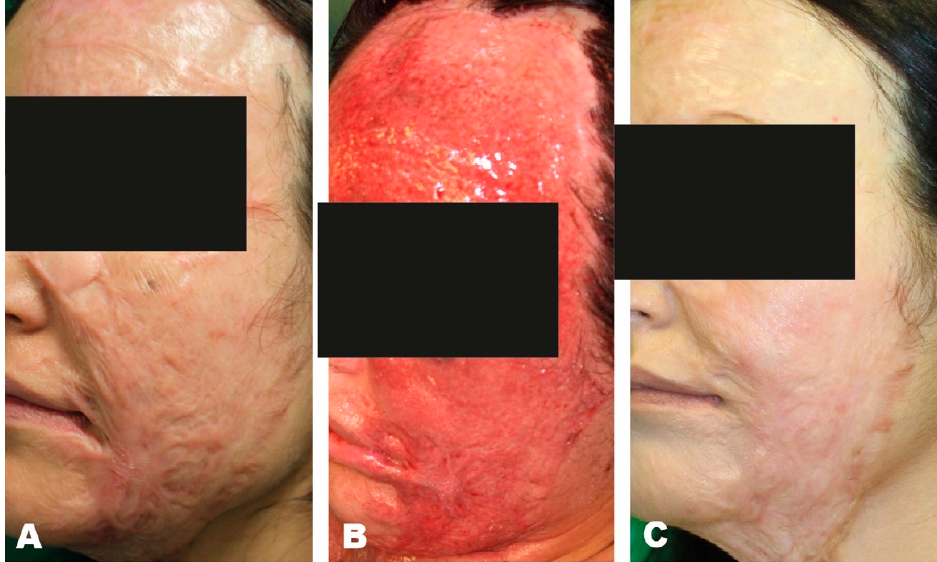
Figure 3. ( A ) Preoperative hypertrophic scar, ( B ) Intraoperative picture after Medical Needling, ( C ) Postoperative outcome after 3 medical needling treatments .